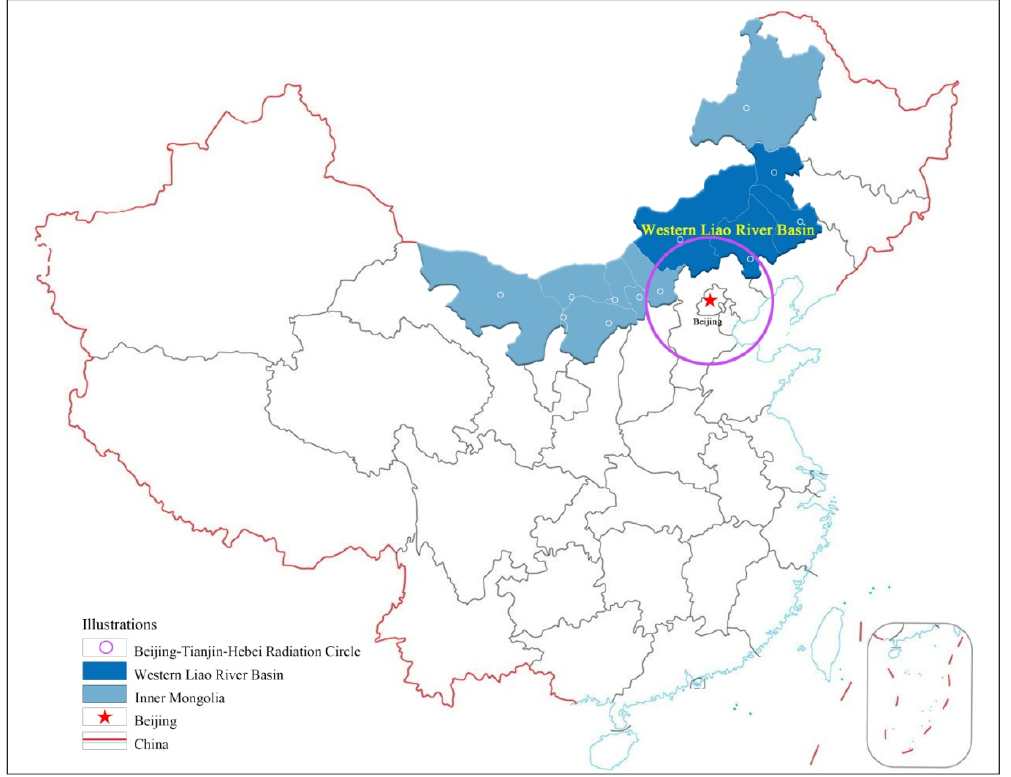
Figure 1. Location map of the Western Liao River Basin in Inner Mongolia.